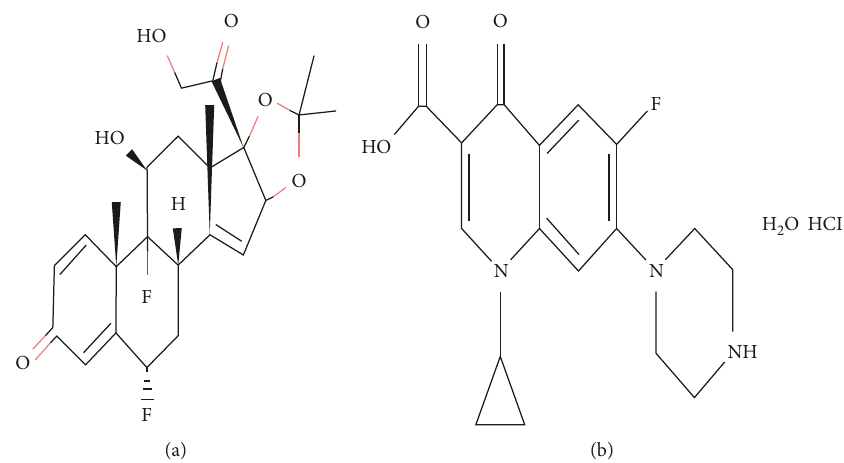
Figure 1: Chemical structure of fluocinolone acetonide (a) and ciprofloxacin hydrochloride monohydrate